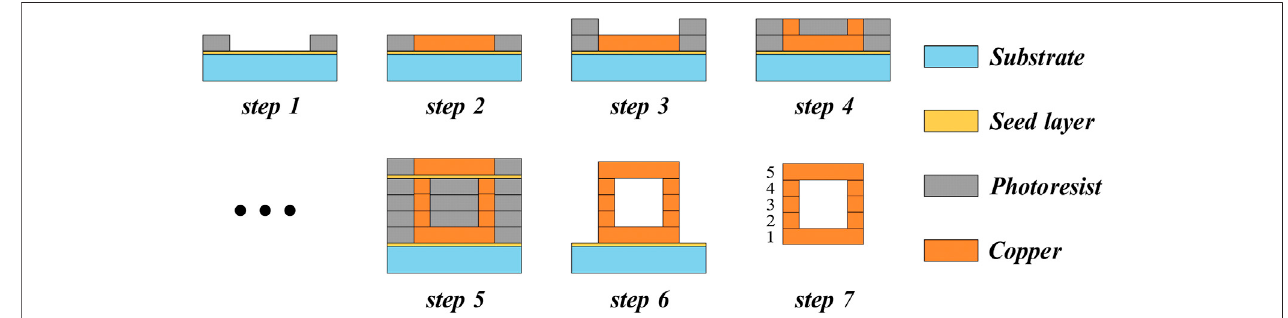
FIGURE 1 | Processing steps of micro-metallic